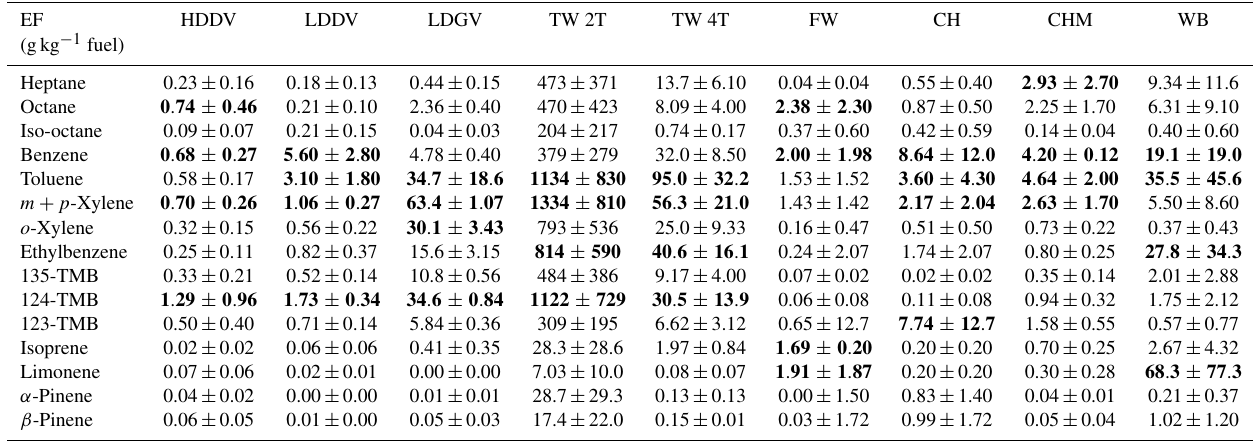
Table 5. EF values of VOC species for the studied sources: heavy-duty diesel vehicles (HDDV), light-duty diesel vehicles (LDDV),